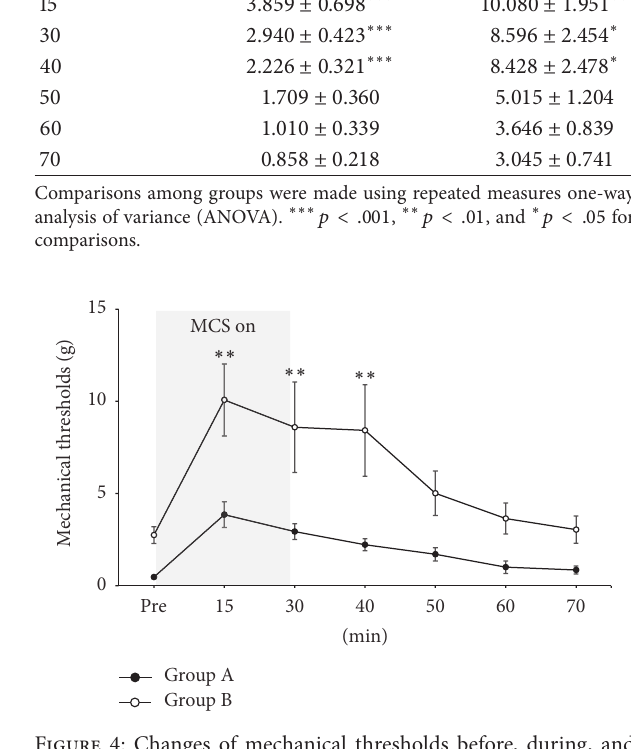
Figure 4: Changes of mechanical thresholds before, during, and after electrical stimulation of motor cortex stimulation (MCS) in Groups A and B. Two groups showed the increment of mechanical thresholds during MCS on, and these antinociceptive effects of MCS lasted for more than 30 minutes even though the electrical stimulation was off state. And the difference between mechanical thresholdsoftwogroupswasstatisticallysignificantuntil40minutes [two-way analysis of variance (ANOVA) with Bonferroni post hoc tests; ∗∗ 𝑝 < .01